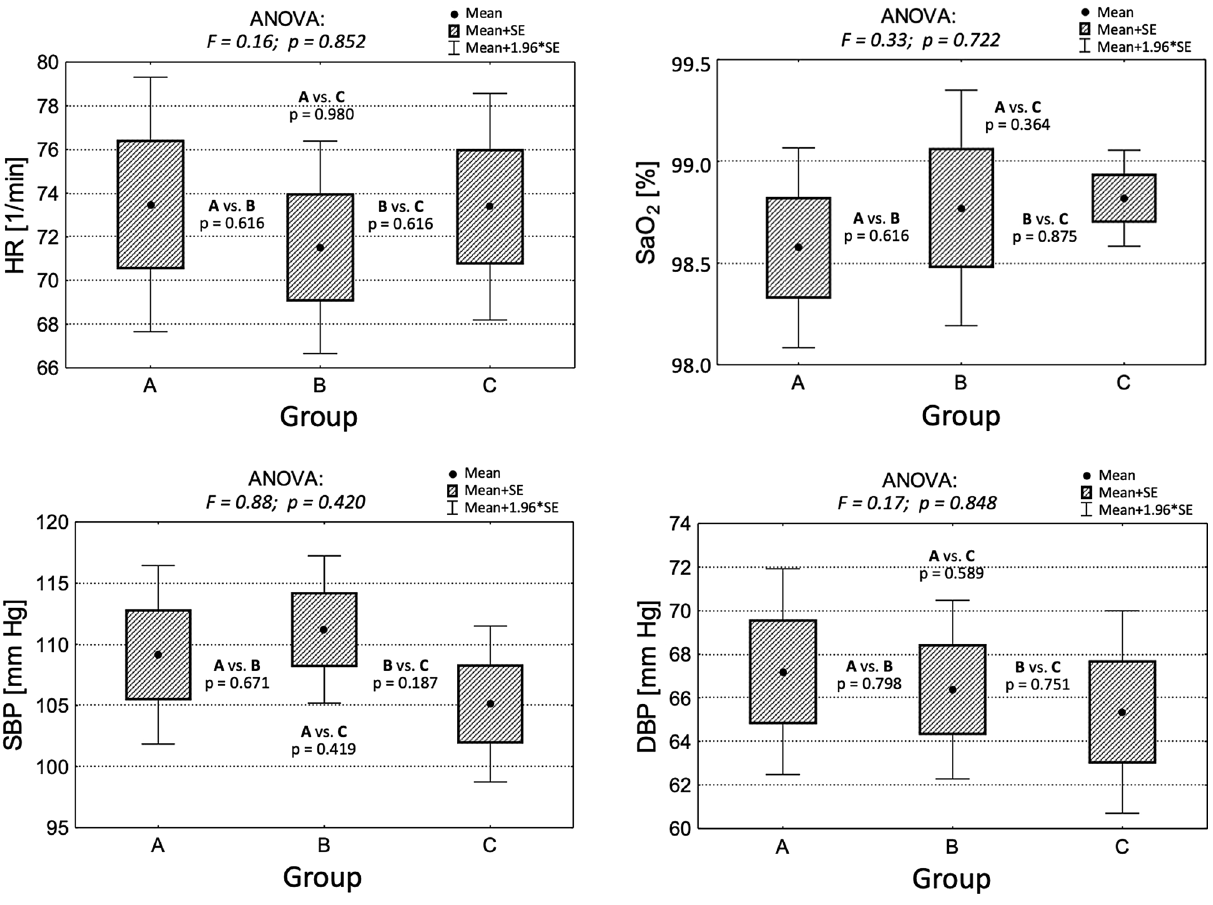
Figure 2. Hemodynamic parameters in groups A, B, and